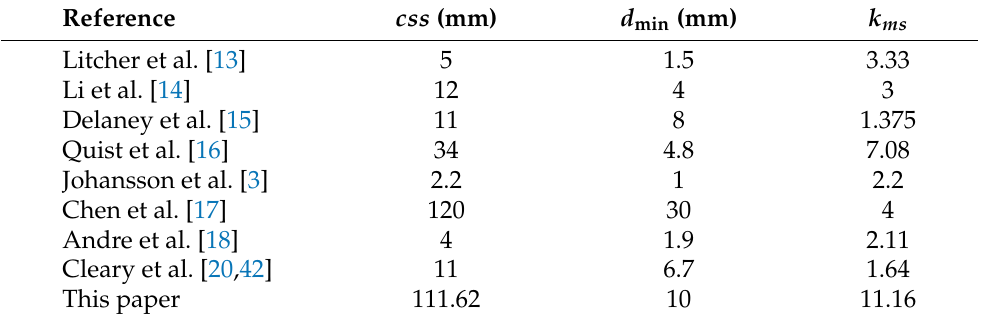
Table 4. Ratio of the minimum simulated size, k ms used in DEM simulations of gyratory and cone